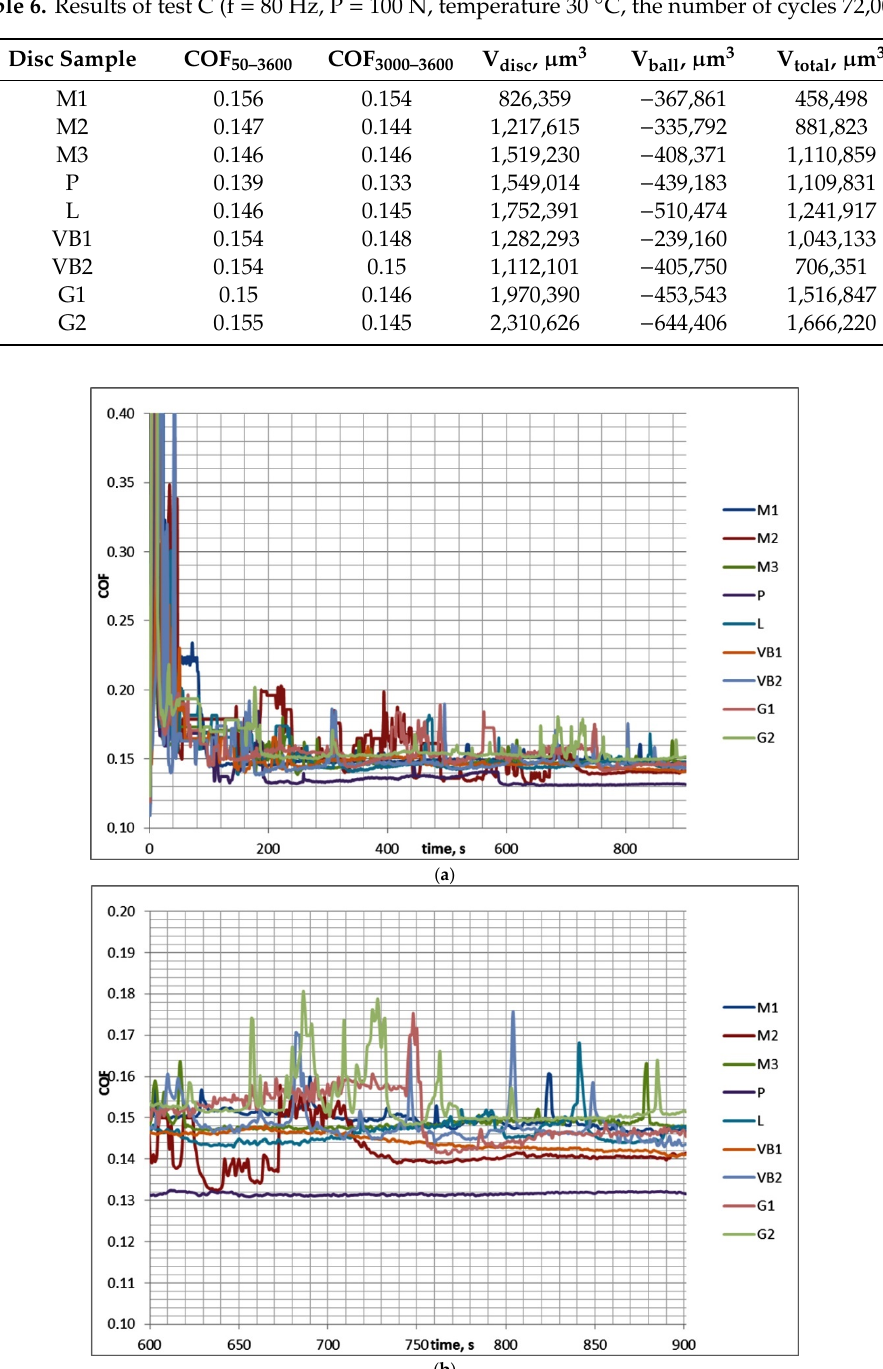
Figure 11. Friction coefficients for whole test C ( a ) and for its last 5 min ( b ).